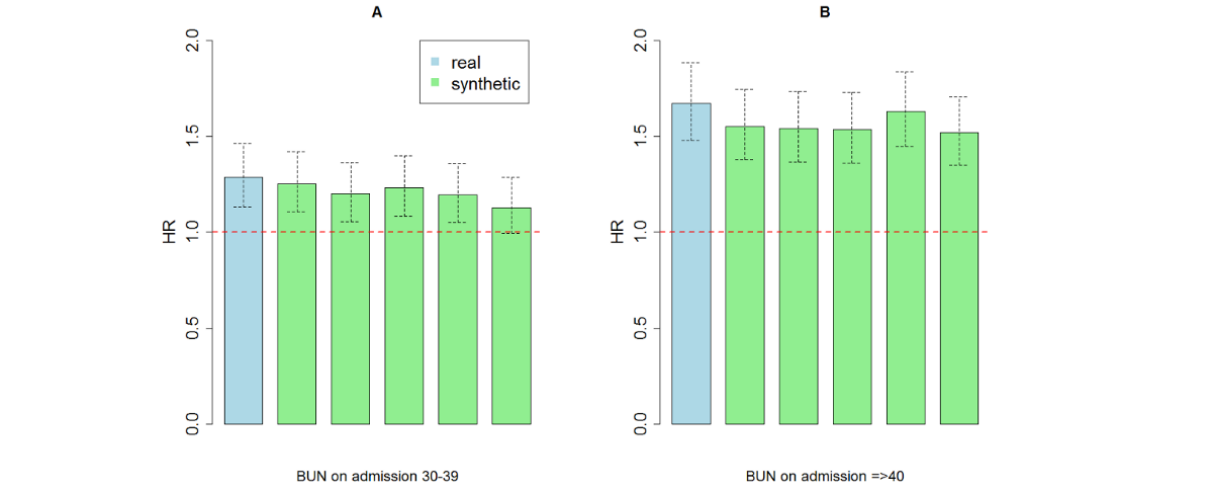
Figure 5. Hazard ratios with confidence intervals by admission BUN level, obtained by Cox proportional hazard regression based on real data and on five synthetic datasets. Hazard ratios relative to the reference group of BUN below 30 based on real data were 1.29 for patients with BUN between 30 and 39 (panel A) and 1.67 for patients with BUN 40 or above (panel B). Hazard ratios estimated from synthetic data were slightly lower. The width of confidence intervals was consistent between the real and the synthetic data, and across the synthetic